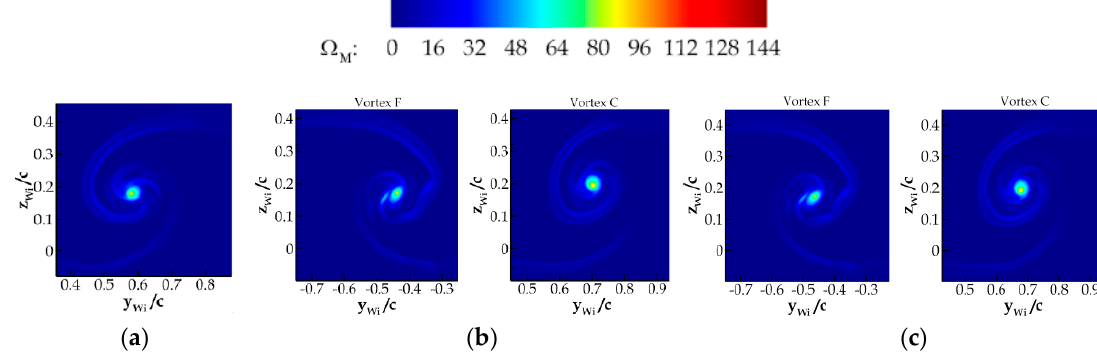
Figure 28. Contours showing the mean vorticity magnitude of Vortex C at x Wi /c = 1.624. ( a ) Straight-line condition; ( b ) Cornering condition; ( c ) Fixed yaw condition.